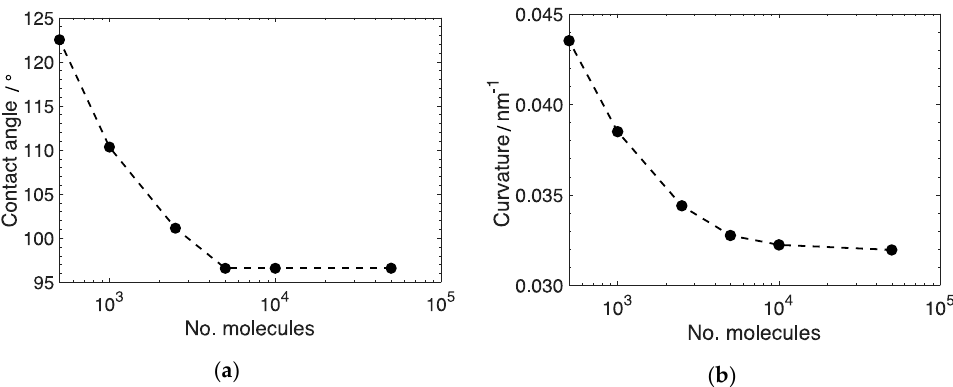
Figure 6. Fluid droplet contact angle ( a ) and curvature on a flat surface ( b ) as a function of the number of fluid molecules. Dashed lines are used to guide the eye.